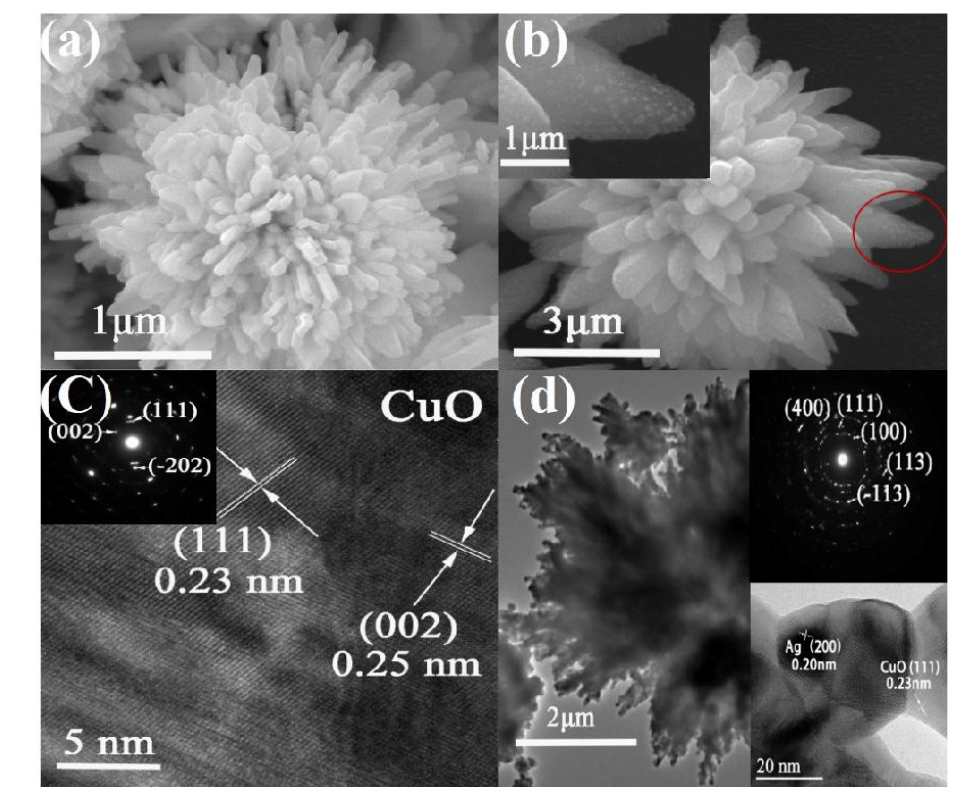
Figure 3. Scanning electron microscope (SEM), selected-area electron di ff raction (SAED), and high-resolution electron microscopy (HRTEM) images of CuO FM and Ag@CuO FM. ( a ) CuO FM; ( b ) Ag@CuO FM; ( c ) CuO FM; ( d ) Ag@CuO